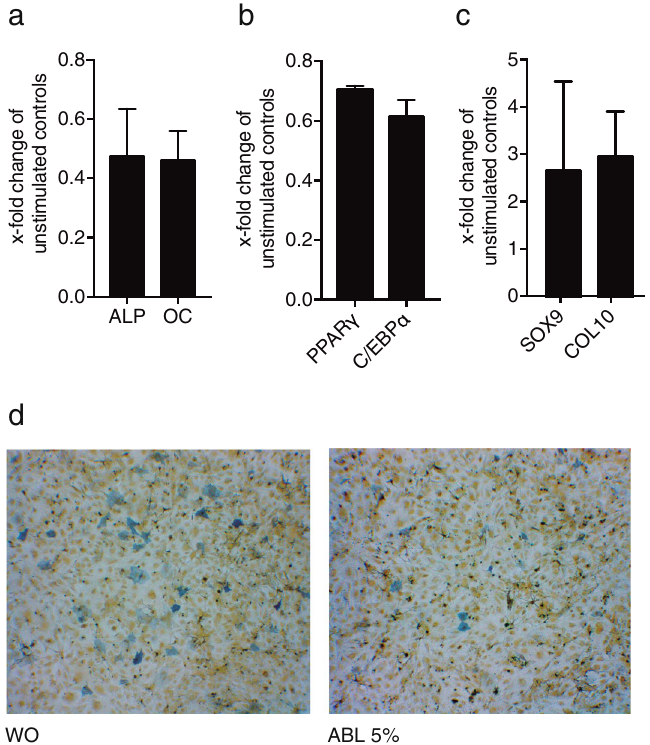
Figure 8. Acid bone lysate (ABL) decreases osteogenic and adipogenic differentiation. Exposure of osteogenic calvaria cells and adipogenic 3T3-L1 cells to ABL caused a considerable decrease of the marker genes alkaline phosphatase (ALP) and osteocalcin (OC) ( a ), as well as PPAR γ and C/EBP ( b ), respectively. Chondrogenic ATDC5 cells showed a moderate increase of SOX9 and COL10 ( c ). Histochemical staining of alkaline phosphatase activity confirmed the findings from gene expression in osteogenic calvaria cells ( d ). N = 3–5. Data represent the mean ±